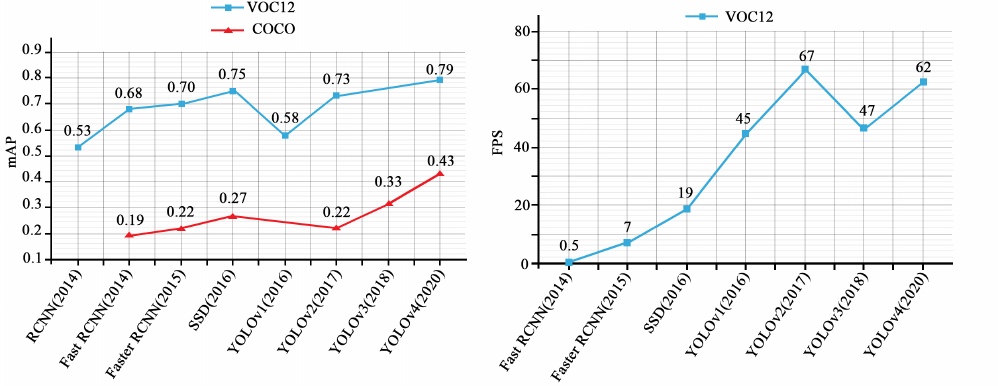
Figure 3. Mean Average Precision (mAP) and Speed (FPS) overview of eight most popular object detection models on Microsoft Common Objects in Context (MS-COCO) and PASCAL Visual Object Classes (VOC)